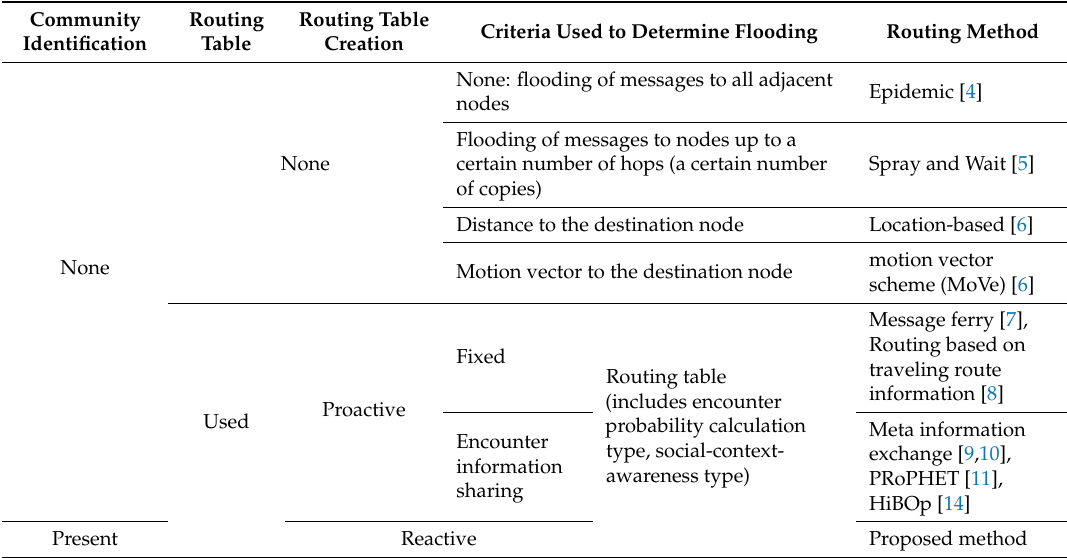
Table 1. Classification of routing methods according to the criteria used to determine flooding and according to routing table creation methods.